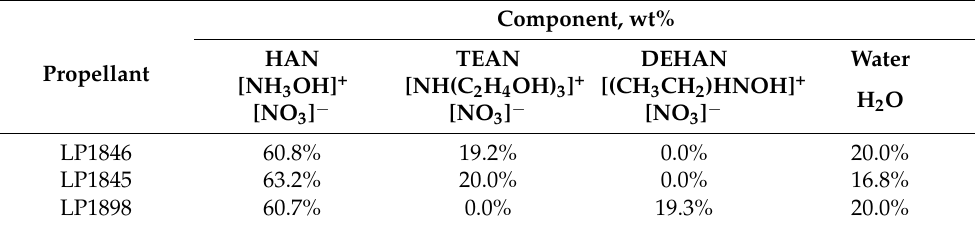
Table 2. Composition of US Army liquid gun propellants (LGPs)